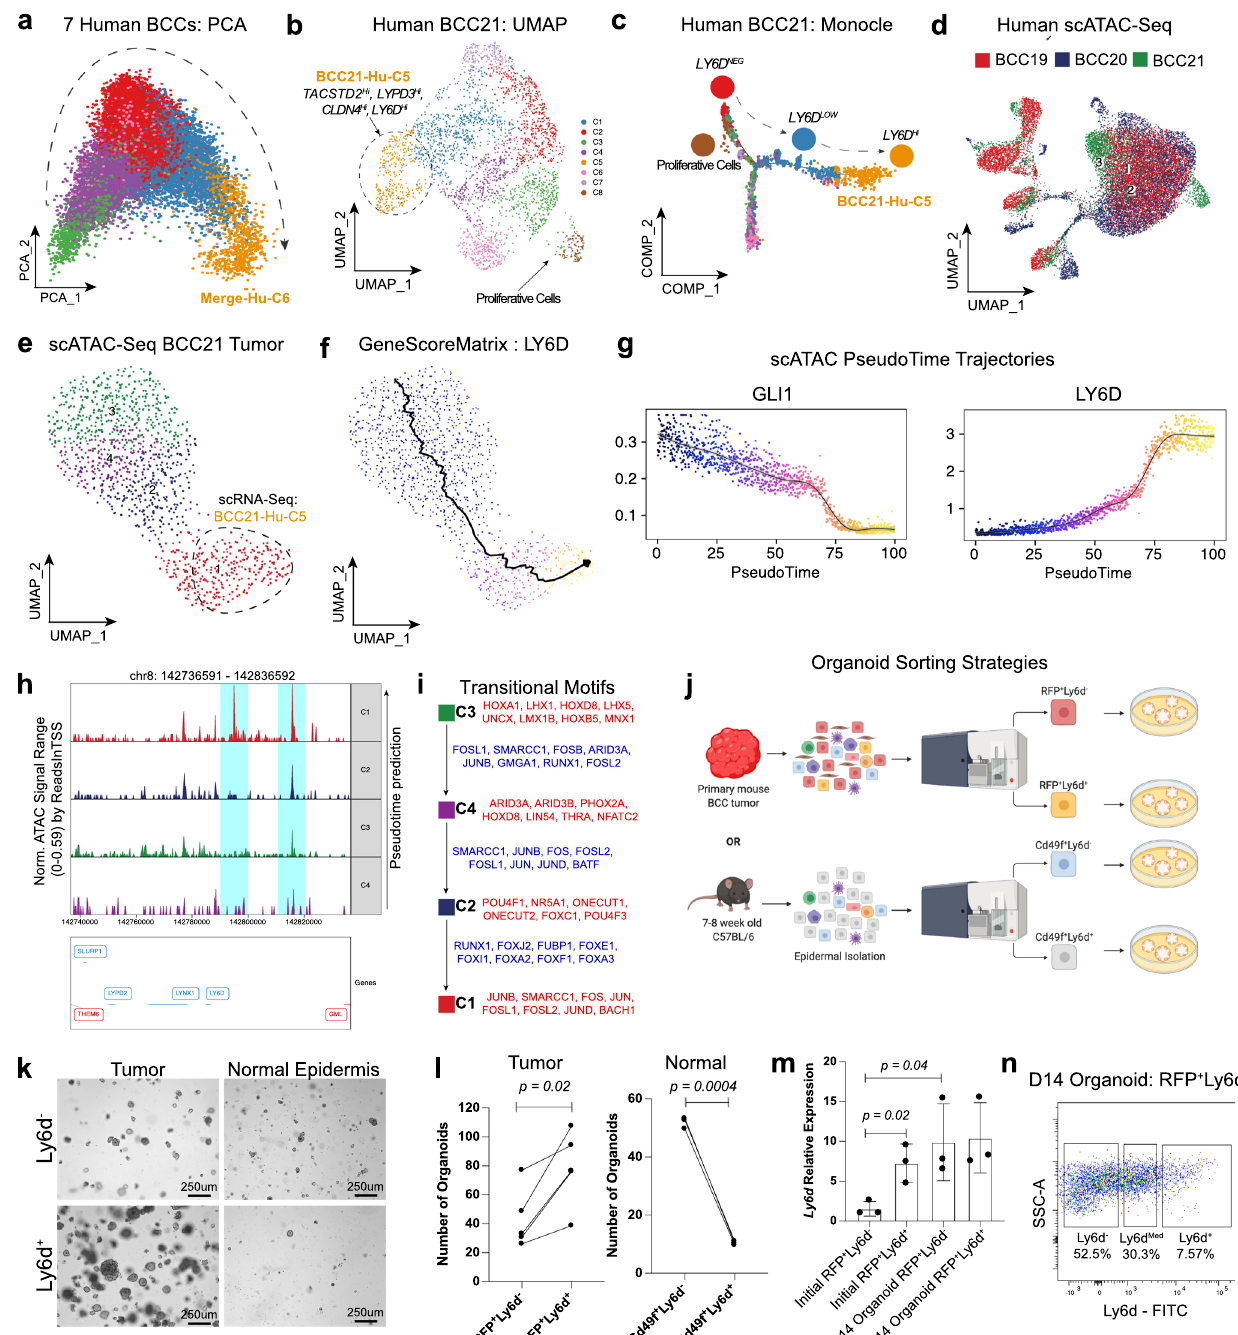
Fig.2|BCCsspontaneouslytransitiontowardsanLY6D + state.a PCAprojection of the seven merged human BCC tumor epithelial samples from Fig. 1b. Arrow indicates presumptive lineage transition. b UMAP plot of scRNA-Seq data from human BCC21 tumor epithelial sample with eight distinct clusters. The circled BCC21-Hu-C5 population, is enriched for indicated markers. c Monocle projection of human BCC21 tumor epithelial sample with the same cluster information from Fig.2b.Arrowindicatestransitionfroman LY6D Neg toBCC21-Hu-C5. d UMAPplotof scATAC-Seq data from three merged human three BCC tumor samples. e UMAP plot of scATAC-Seq data from human BCC21 tumor epithelial sample with four distinctclusters. f Featureplotofthe GeneScoreMatrix for LY6D forhumanBCC21 scATAC-Seq data as shown in Fig. 2e. Monocle projection overlayed the predicted lineage transition. g scATAC-Seq lineage trajectories for GLI1 and LY6D. h Chromatin accessibility for around LY6D locus for each cluster from human BCC21scATAC-Seq. LY6D is on the negative strand (genes in blue). Peaks enriched